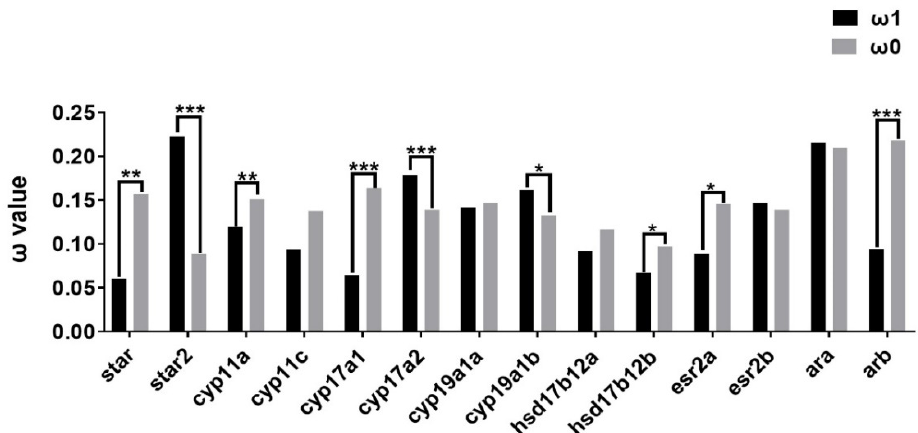
Figure 4. Molecular evolution of the putatively duplication originated steroidogenic genes in teleost lineages with branch model tests. Black and grey columns indicate ω values of the foreground branch and background branch, respectively. * indicates p < 0.05, ** indicate p < 0.01, *** indicate p <